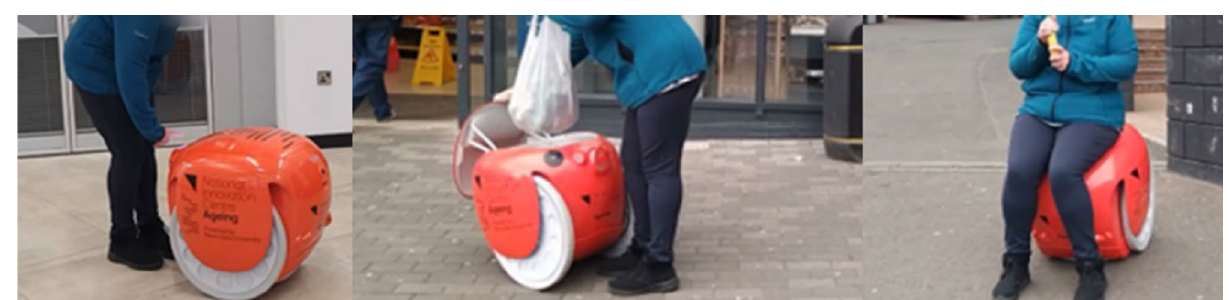
Figure 3. The screenshots of the video featuring a short shopping trip using the human-following robot